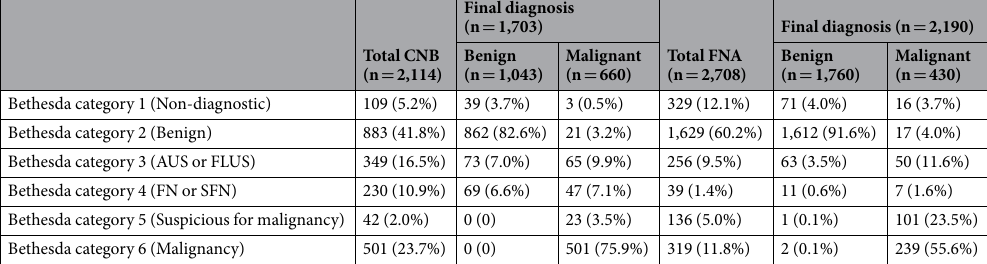
(Supplementary Table 3). The sensitivities (60.8%, 194 of 319, vs. 60.9%, 81 of 133, respectively) and specificities (100%, 768 of 768, vs. 99.9%, 1,098 of 1,099, respectively) were consistently similar between two groups. Discussion